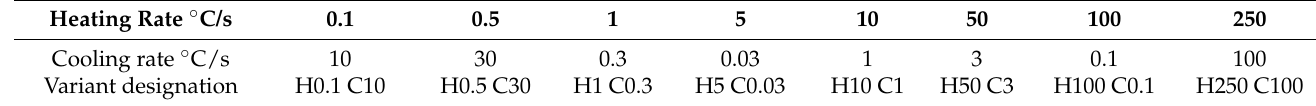
Table 5. The chosen variants for analyzing the shift in transformation temperatures A c1 and A c3